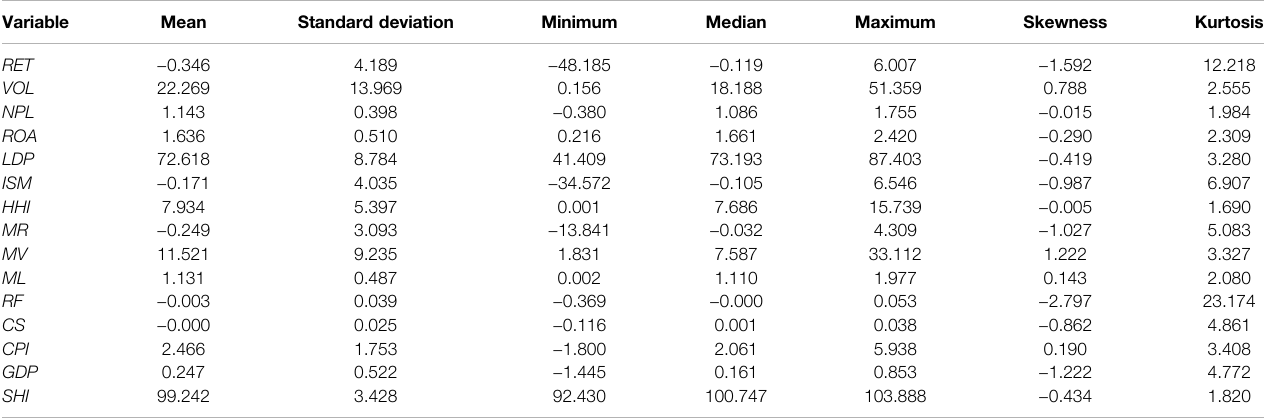
Sample size n = 7882.